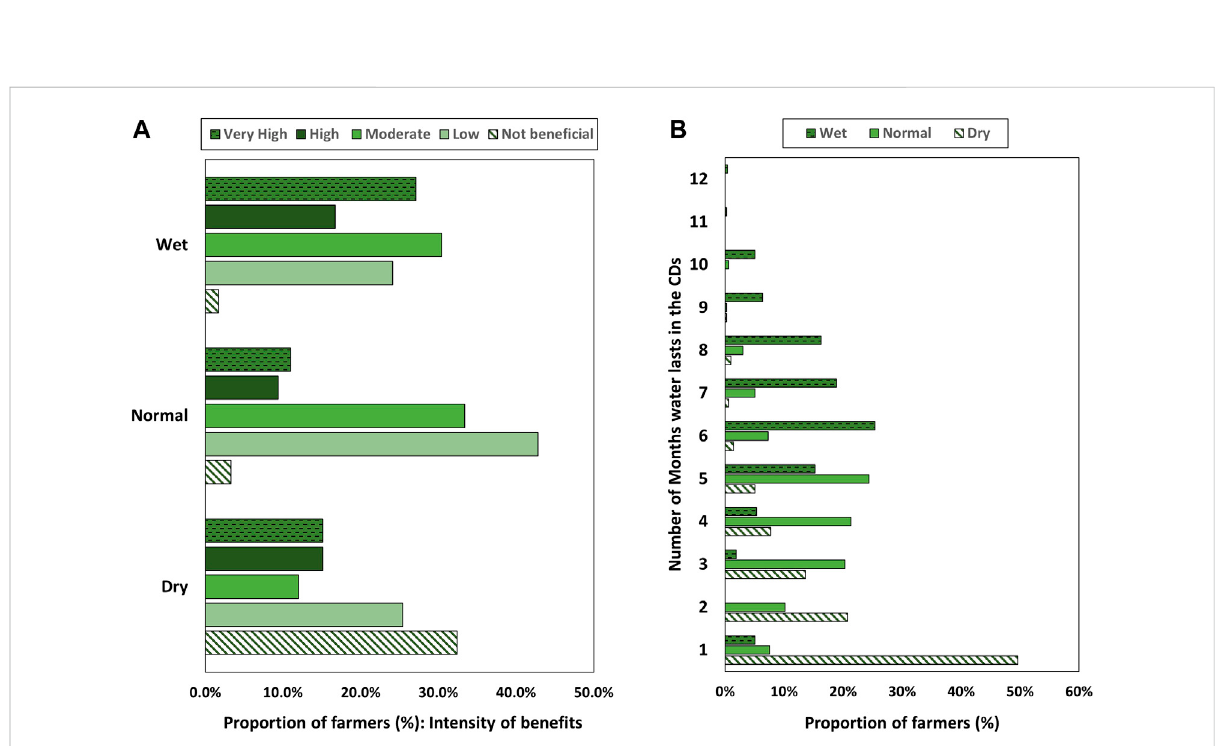
FIGURE 3 (A) Distribution(asaproportionoffarmers)oftheintensityofbene fi tsreportedfordry,normal,andwetyears; (B) Distribution(asaproportionof farmers) of the number of months till which water lasts in CDs for dry, normal and wet